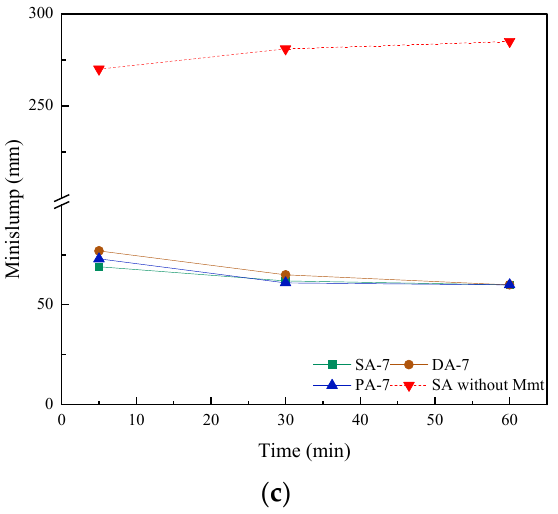
Figure 2. Effect of different addition methods on the minislump of cement paste with different substitutions of Mmt: ( a ) 3% Mmt substitution rate; ( b ) 5% Mmt substitution rate; ( c ) 7% Mmt substitution rate.